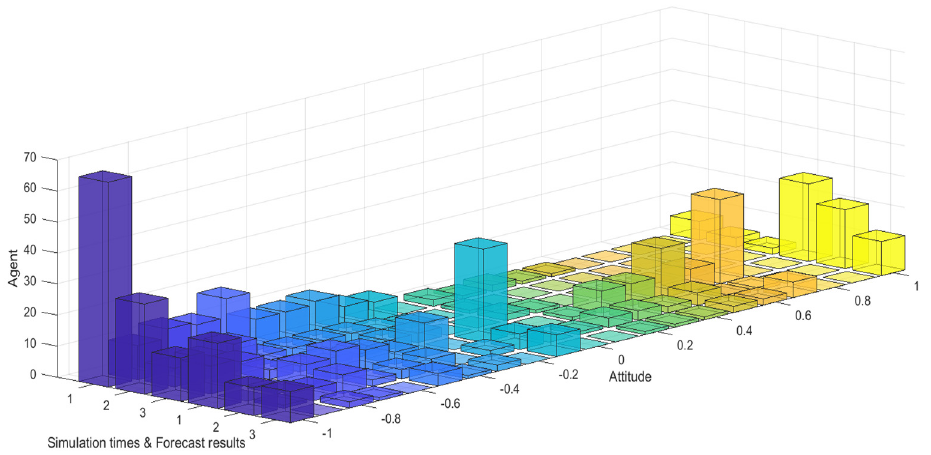
Healthcare 2020 , 8 , x Figure 31. Simulated public opinion evolution diagram. Figure 31. Simulated public opinion evolution diagram.